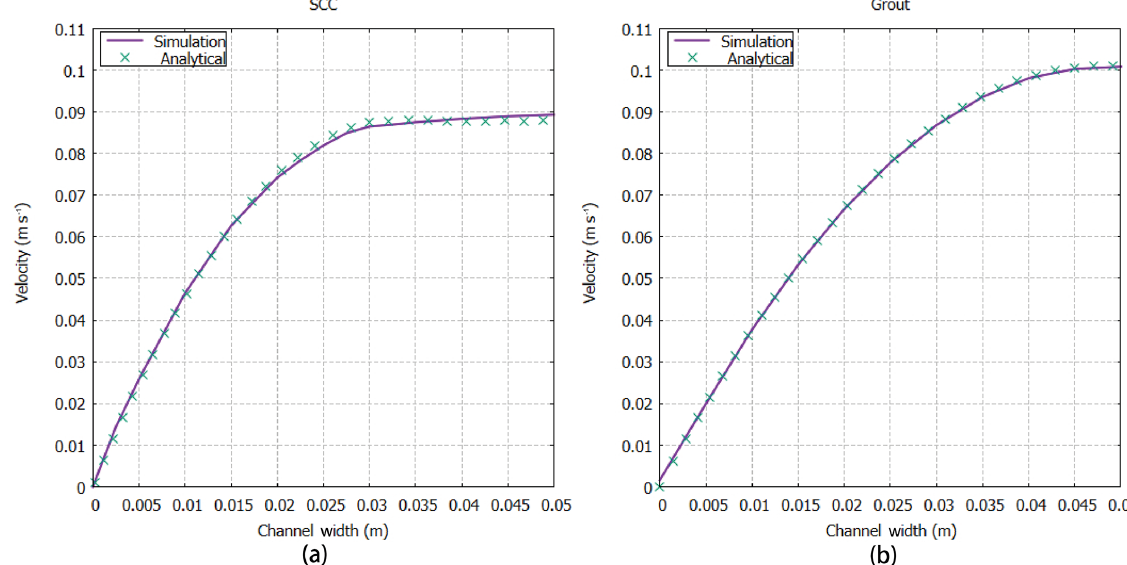
Figure 2. Comparison of velocity variation between analytical solutions (Gopala et al., 2011) and numerical results simulated in two parallel plates based on different rheological parameters, i.e., (a) SCC and (b) grout.